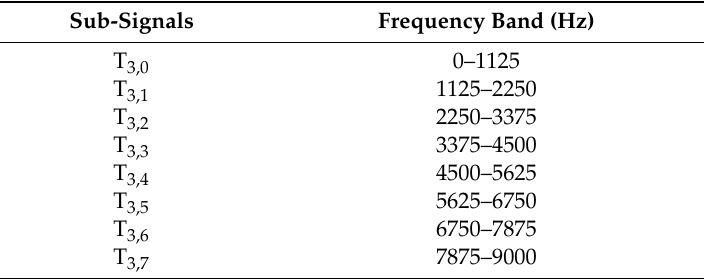
Figure 9. Tree structure of the three-layer stationary wavelet packet transforms. Table 4. Frequency band of each sub-signal in the SWPT.